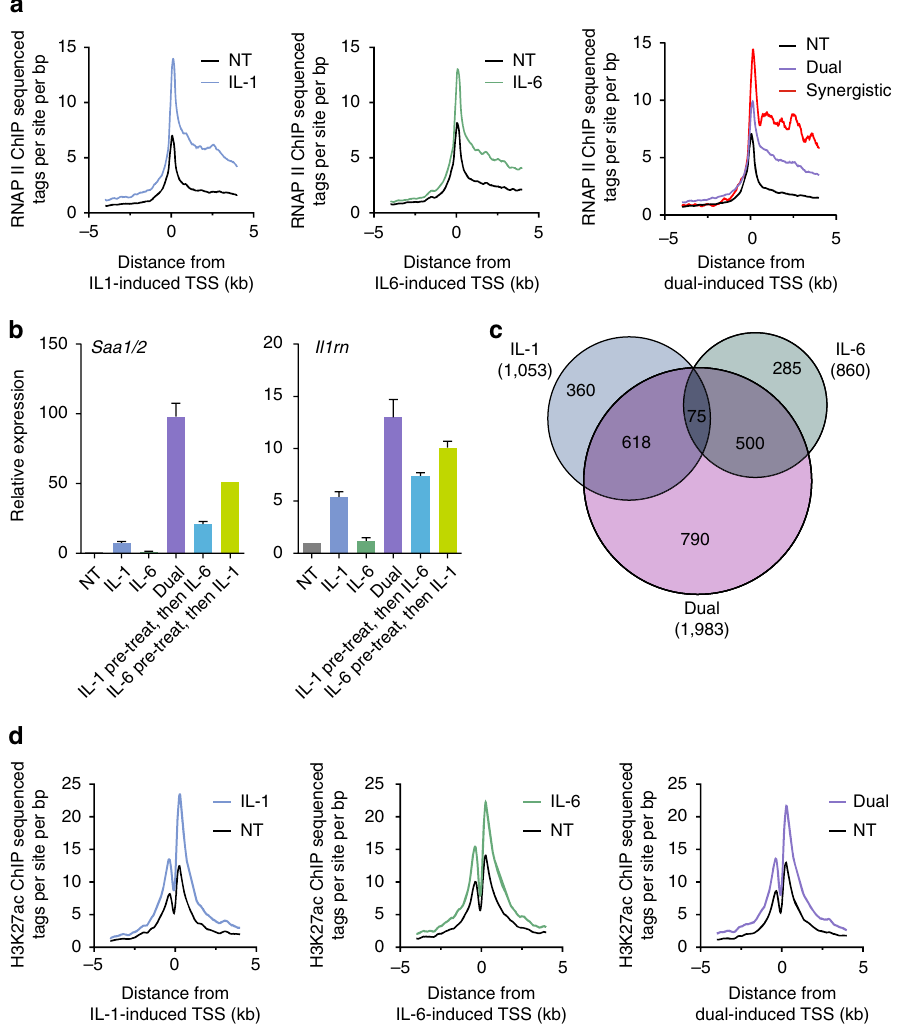
Fig. 2 Cytokines globally alter hepatocyte enhancer dynamics and RNAP II occupancy. a RNAP II occupancy in cytokine-induced genes increases in a cytokine-dependent manner. b Nascent RNA levels of Saa1/2 and Il1rn in primary hepatocytes sequentially treated with either IL-1 β or IL-6 for 6 h followed by a 2 h treatment with the second cytokine. Compare to simultaneous 2 h treatment (dual). Representative experiment shown of at least three independent repeats. Error bars represent s.d. of three technical replicates. c Venn diagram portraying cytokine-induced enhancers and their different response under the various treatments. Enhancers were de fi ned as genomic regions enriched with H3K27ac in accordance with common practices in the fi eld. Throughout the study, analyses include all H3K27ac regions (both regions proximal and distal to transcription start sites). d H3K27 acetylation in the vicinity of cytokine-induced genes increases in a cytokine-dependent manner. TSS transcription start